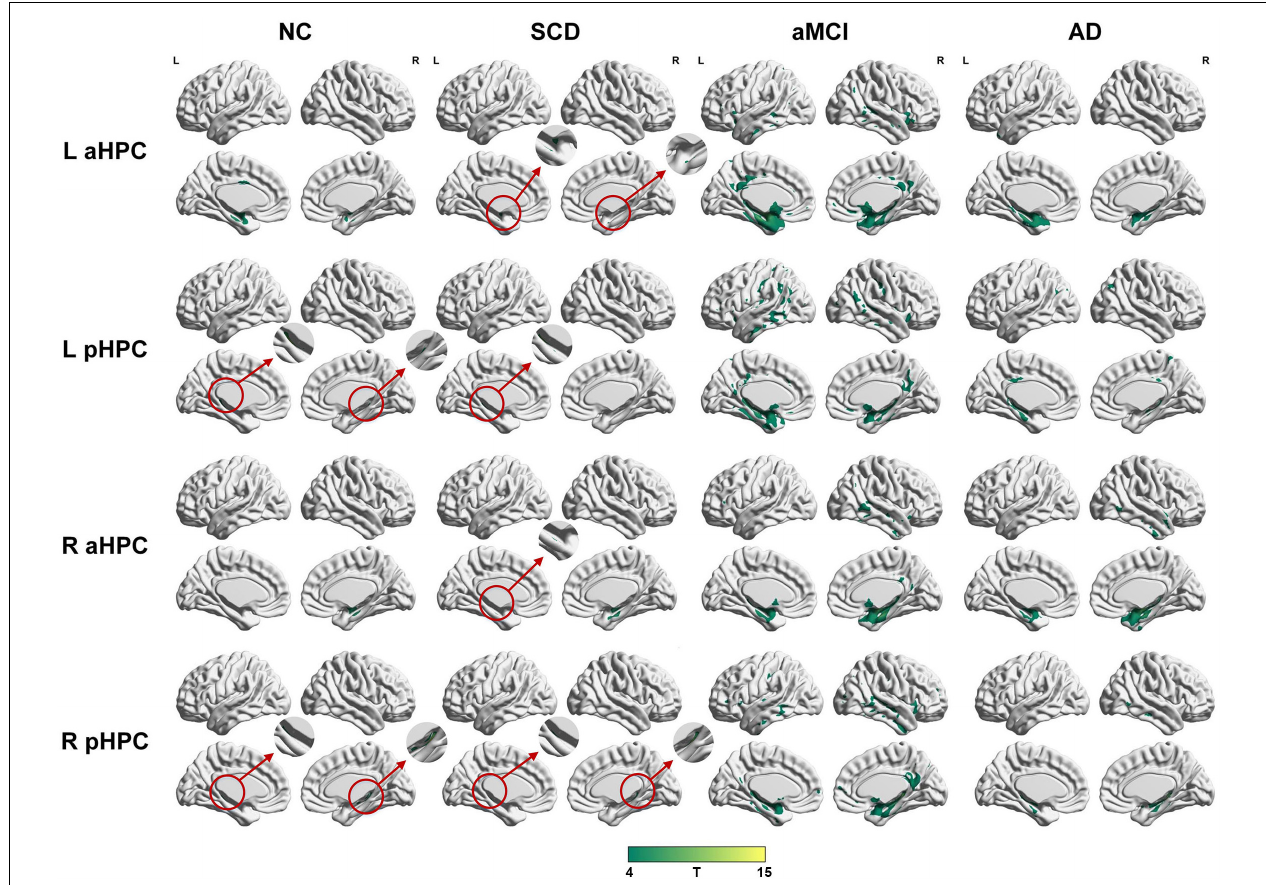
FIGURE 2 | Structural covariance networks seeding from the anterior and posterior hippocampus within groups. T-statistic maps, p < 0.05, corrected by false discovery rate (FDR) with cluster size larger than 100 voxels. The small clusters are circled by the red circles, and they are enlarged. L, left; R, right; aHPC, anterior hippocampus; pHPC, posterior hippocampus; AD, Alzheimer’s disease; NC, normal control; aMCI, amnestic mild cognitive impairment; SCD, subjective cognitive decline.